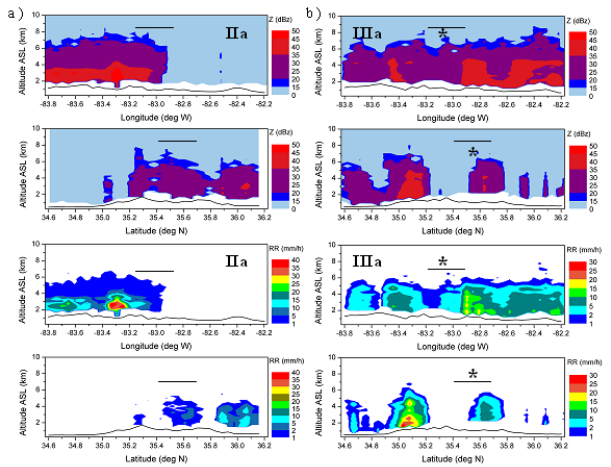
Fig. 7: Cross section of reflectivity (Z) and rain rate estimates (RR) from TRMM 2A25: a) At approximately 2126UTC on 08/26/08 (tropical storm Fay) and corresponding to the situation IIa. b) At approximately 1321UTC on 05/06/09 and corresponding to the situation IIIa. Horizontal bars indicate the approximate location of the GSMNP rain gauge network (RG0XX-RG1XX). The star indicates the approximate location of RG100-101-102-104-109. Locations of the cross sections are reported in Fig. 1.